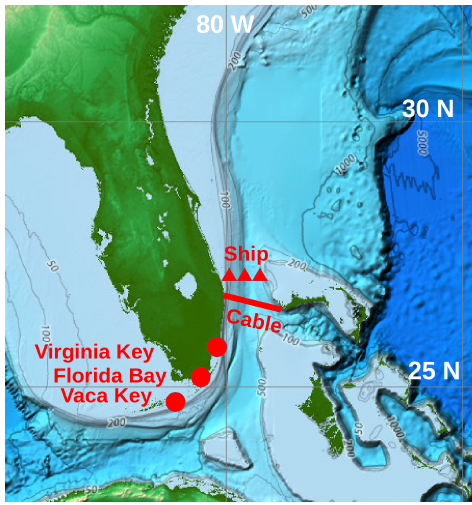
Figure 1. Map of Florida Straits with the cable, tide gauge, and ship measurement locations. Bathymetry contours are in